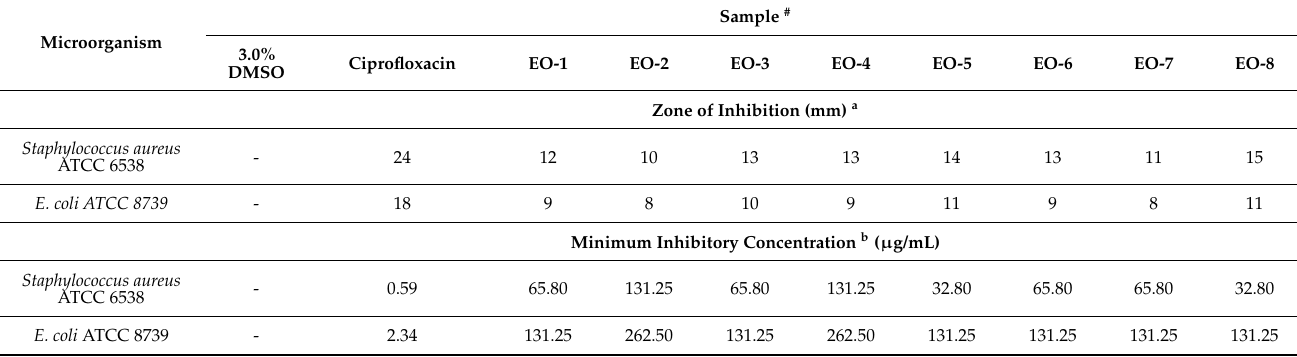
Table 2. Antibacterial activity of R. coriaria L essential oils (Sumac EO, 1–8) from the Jordanian market and agricultural field.